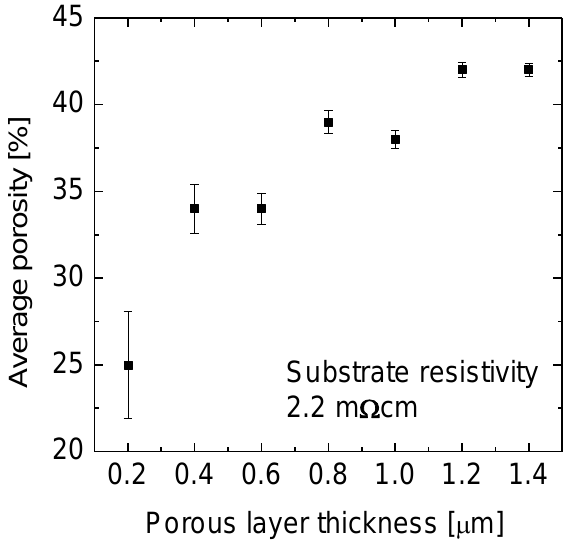
Figure 2. The average porosity as a function of the etching depth into a Si wafer with a resistivity of 2.2 m  cm. The wafers were etched in the temperature controlled aqueous HF-rich stain etching solution. The etching solution was fed with silicon before the first sample was immersed. The average porosity increases from 25% at a layer thickness of 0.2 µm to 42% at 1.4